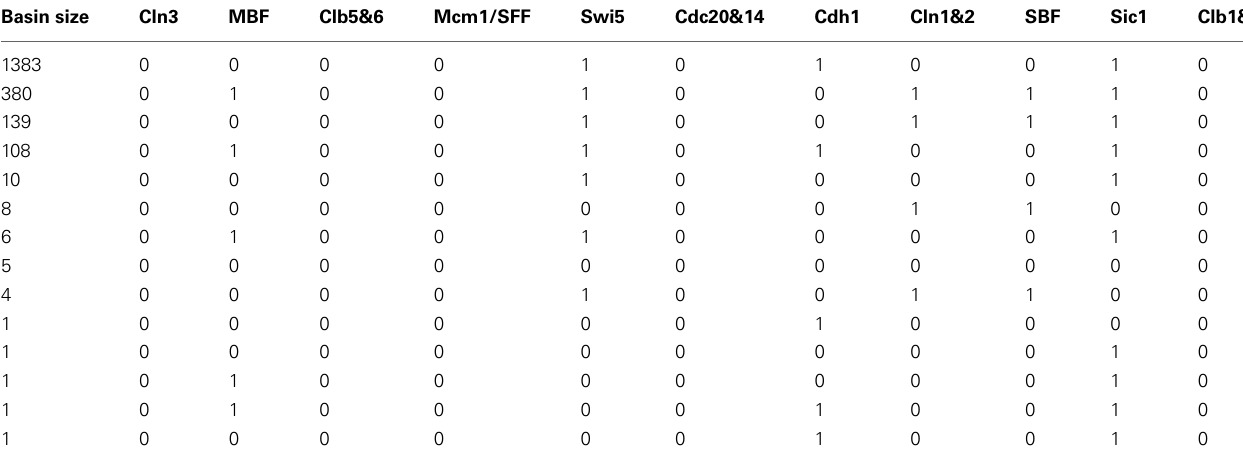
Table 2 | The attractor set for the cell-cycle threshold Boolean network which does not contain Swi5’s self-degradation property. Basin